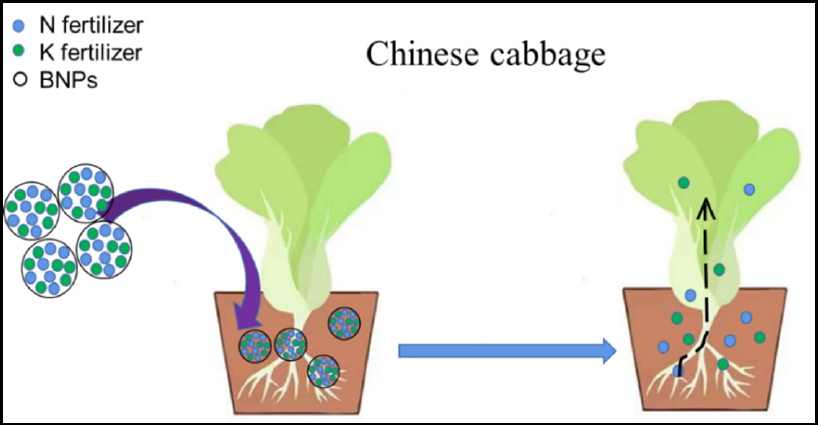
Figure 6. The potential mechanism of BNPs working as nanocarriers to regulate Chinese cabbage growth.